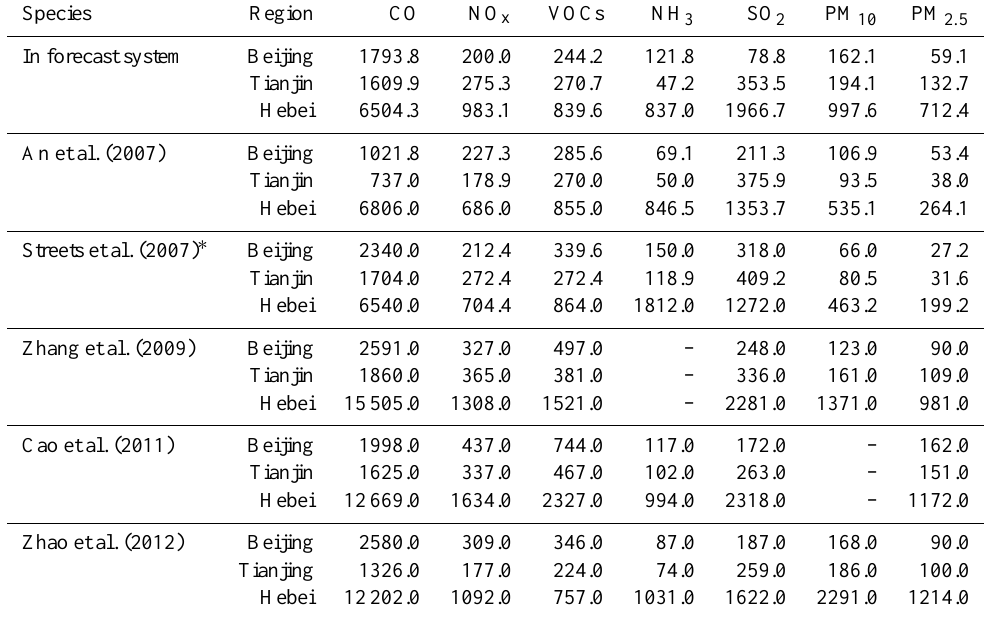
Table 1. Emission of major anthropogenic species (unit: 10 3 t yr − 1